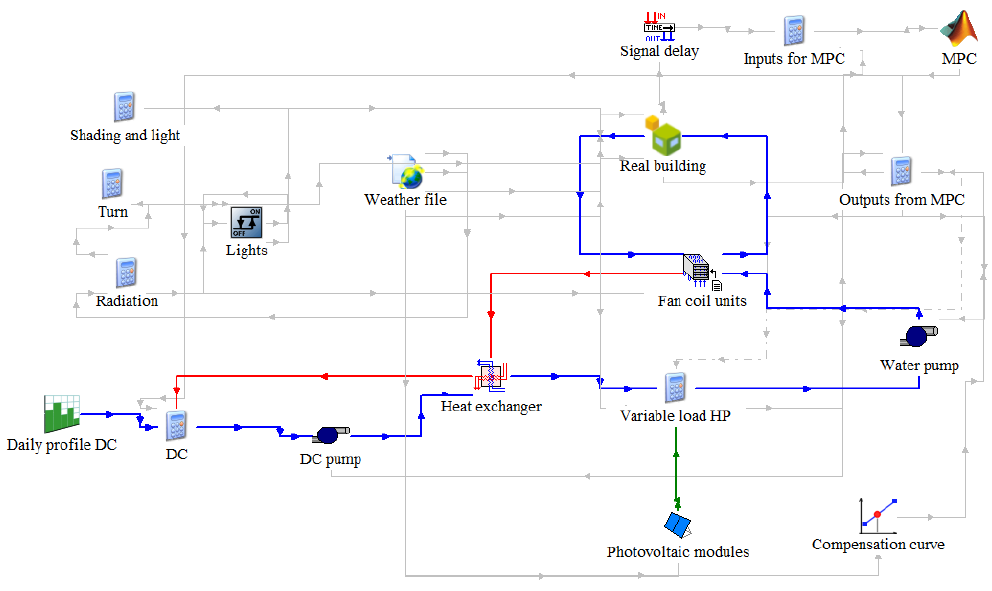
Figure 8. TRNSYS model layout.